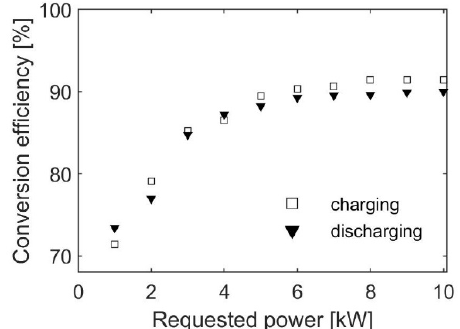
Figure 9. EVSE conversion efficiency for the requested power set points, both in charge (squares) and discharge (filled triangles) modes. The performance degrades for requested power values that fall below 5 kW (50% of the EVSE nominal power). Each value represents the average of four identical tests, with a standard deviation ranging ±0.2% and ±0.8%.